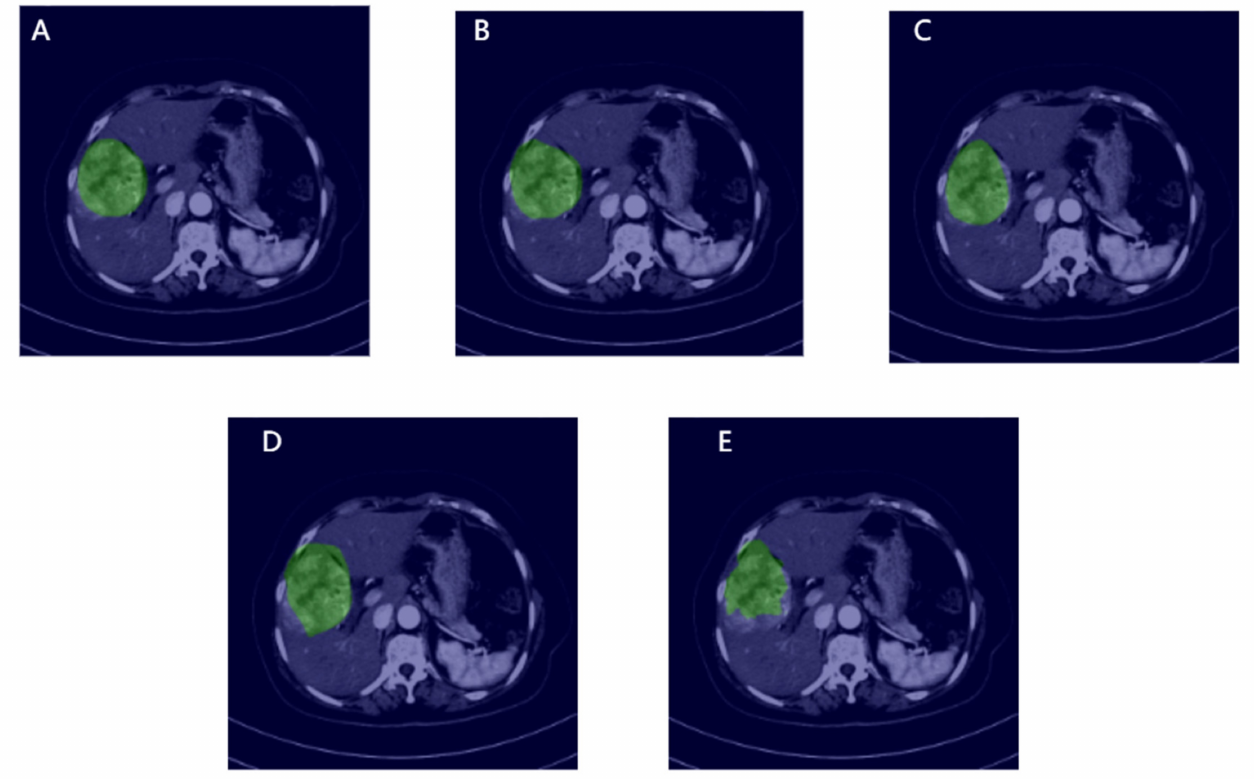
Figure 5. Visualization of manual annotation and segmentation of each model, in which the green area is the ROI, and the rest are the original slices: ( A ) Represents manual annotation; ( B – E ) represent MVI-Mind, Swin Transformers, DeepLab V3+, U-Net segmentation,